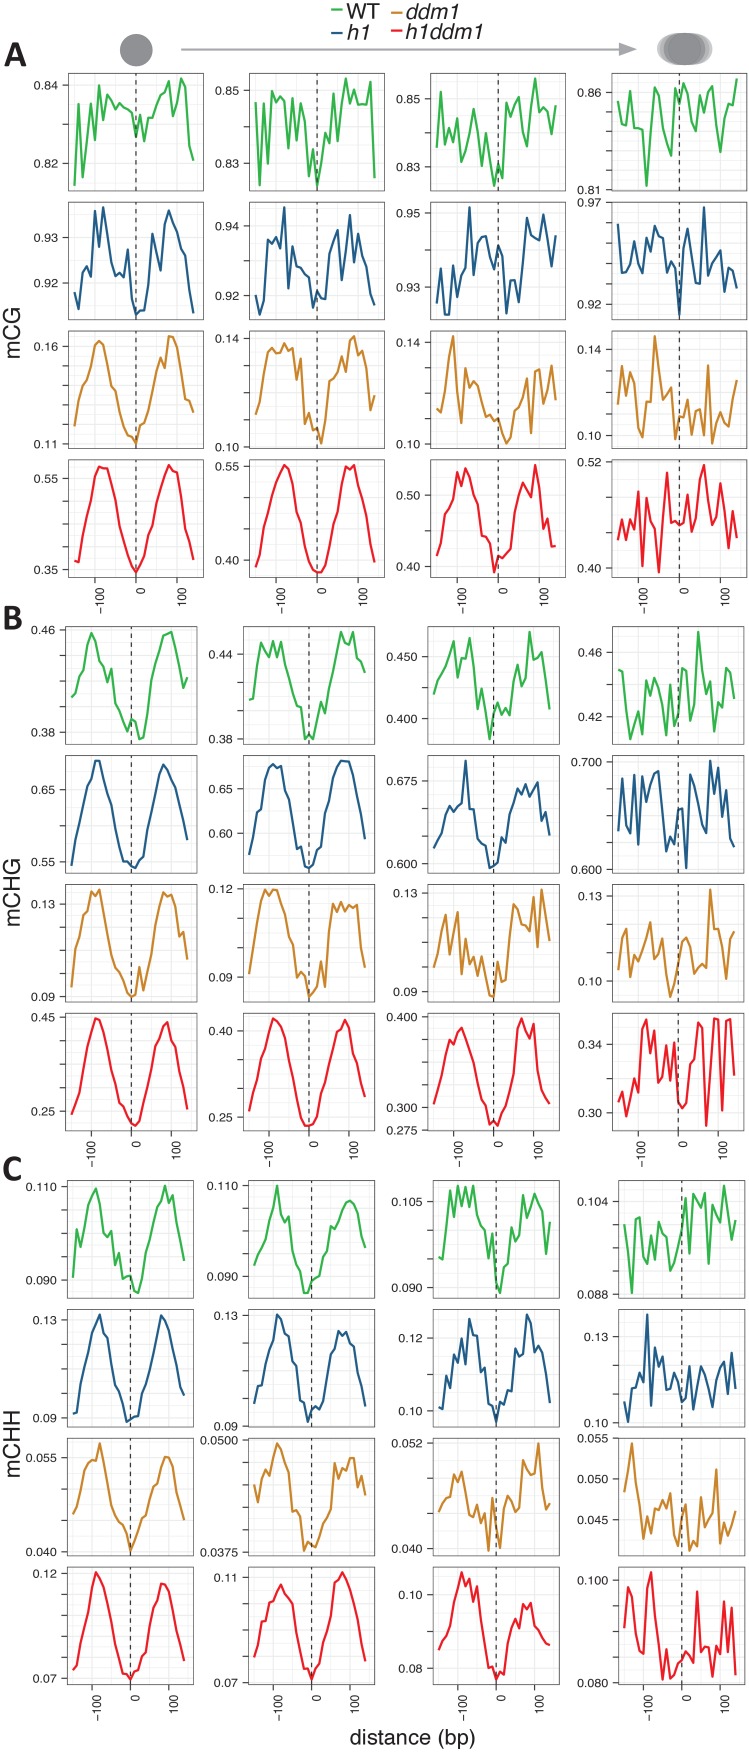
DNA methylation around nucleosome cores.Methylation is plotted as described in Figure 1A,D and E for CG, CHG, and CHH contexts respectively. Note that Y-axis scales vary between genotypes.